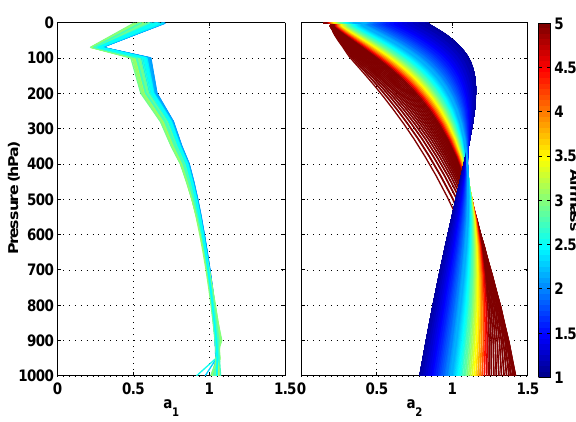
Fig. A2. Column averaging kernels for ACOS-GOSAT (left panel) and TCCON (right panel) over Lamont, coloured by the